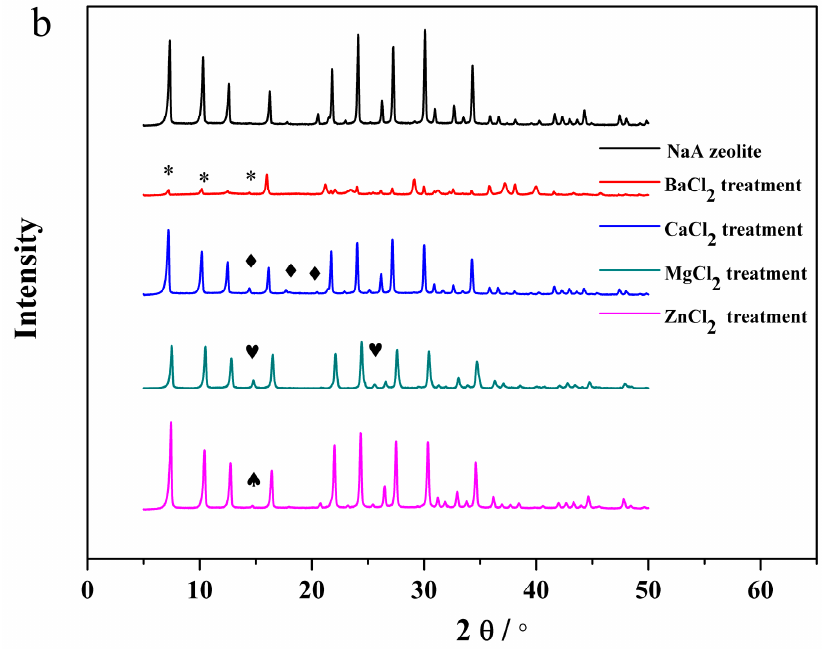
Figure 5. X-ray diffraction (XRD) patterns of NaA zeolite seeds and after treatment seeds with ( a ) monovalent cations and ( b ) divalent cations. Table 3. Inductively coupled plasma (ICP) tests of NaA zeolites treated by different cations. Type Relative Content of Na Relative Content of Positive Charge a NaA zeolite NaCl treatment